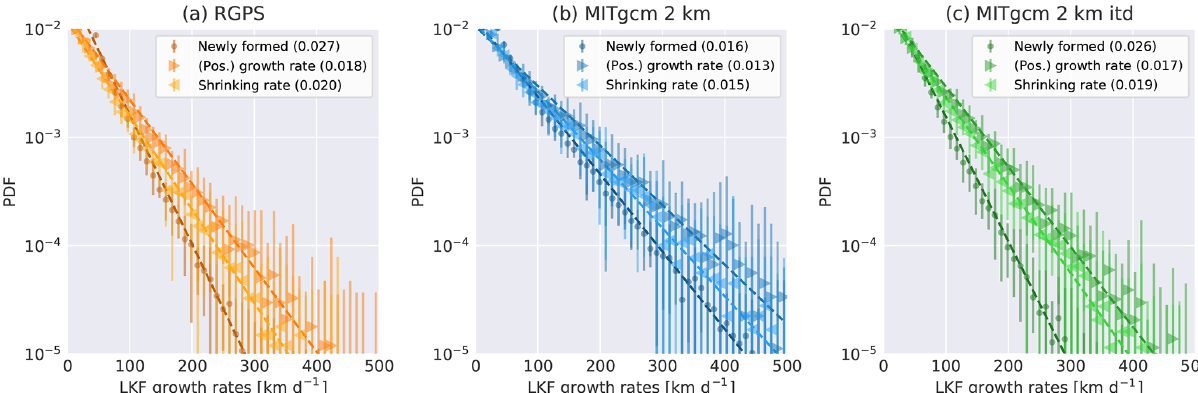
Figure 11. Mean (symbols) and standard deviation (vertical bars) of the growth rates of LKFs in RGPS data and both simulations. We differentiate between the growth rate, the shrinking rate, and the growth rate of newly formed LKFs. The dashed lines are fits to exponential tails, the rate parameter of which is given in the legend. For the analysis presented in this figure the LKF datasets of both simulations are filtered for RGPS